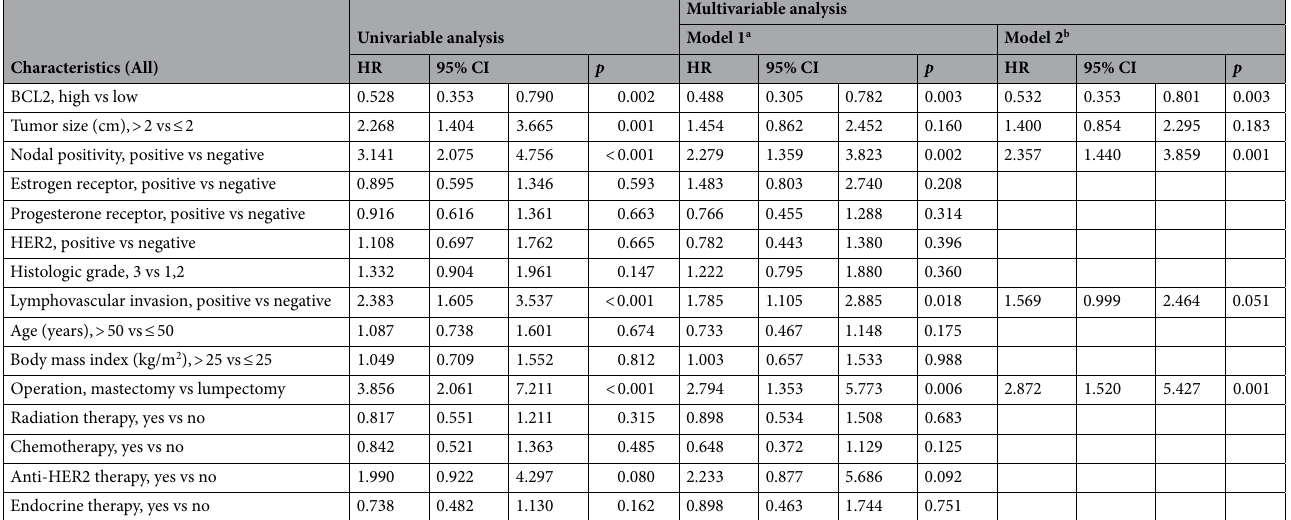
Table 2. Univariable and multivariable analyses regarding disease-free survival. CI confidence interval, HER2 human epidermal growth factor receptor 2, HR hazard ratio. a BCL2 factor was adjusted with all of 14 clinicopathologic factors including tumor size, nodal positivity, estrogen receptor, progesterone receptor, HER2, histologic grade, lymphovascular invasion, age, body mass index, operation, radiation therapy, chemotherapy, anti-HER2 therapy, and endocrine therapy. b BCL2 factor was adjusted with 4 clinicopathologic factors, which were statistically significant by univariable analysis, including tumor size, nodal positivity, lymphovascular invasion, and operation.